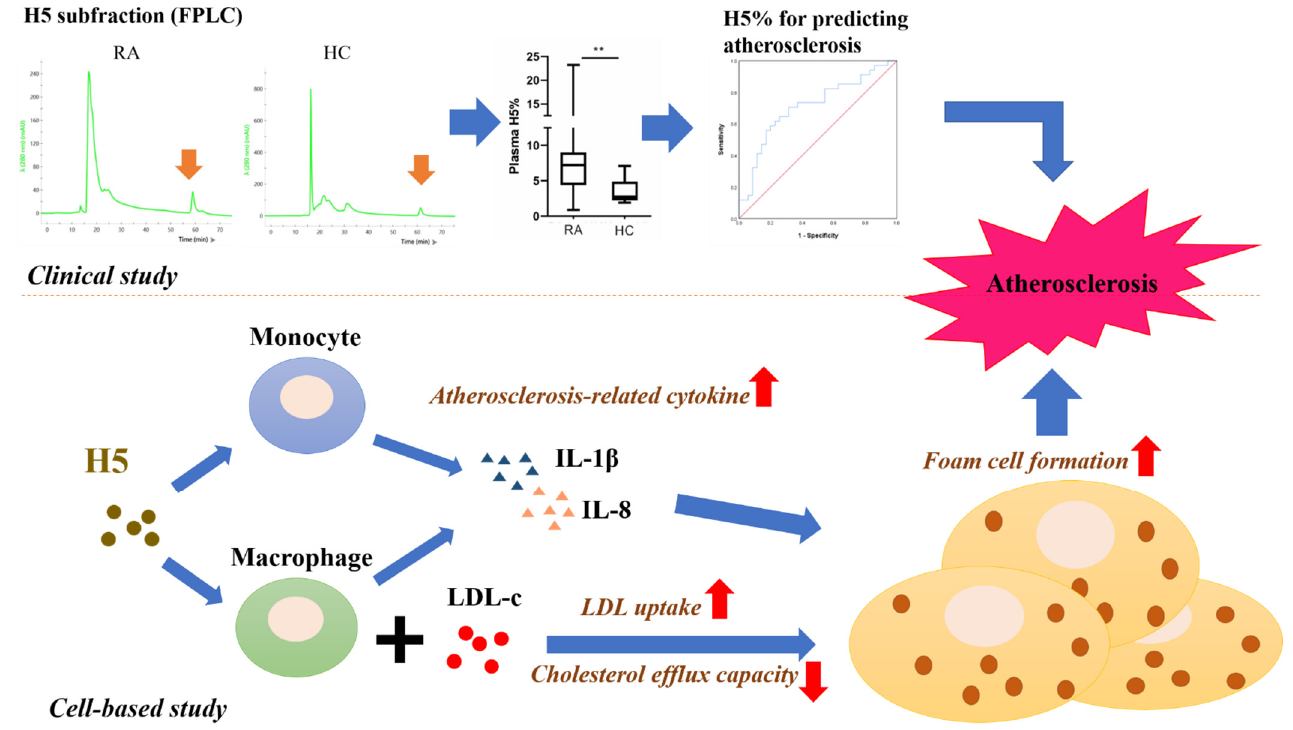
Figure 6. The potential role of H5 with RA-related atherogenesis in clinical and cell-based study. Fast protein liquid chromatography (FPLC) analysis shows higher H5% in RA than health control. The multivariable logistic regression analysis revealed H5% as a significant predictor of the presence of subclinical atherosclerosis. In cell-based experiments, H5 could promote the proinflammatory cytokine of IL-1 β and IL-8, both cytokines significantly related to arteriosclerosis. Moreover, H5 has poor cholesterol efflux and promotes macrophages to uptake more LDL, leading to more foam cells formation, resulting in the occurrence of atherosclerosis. ** p < 0.005.